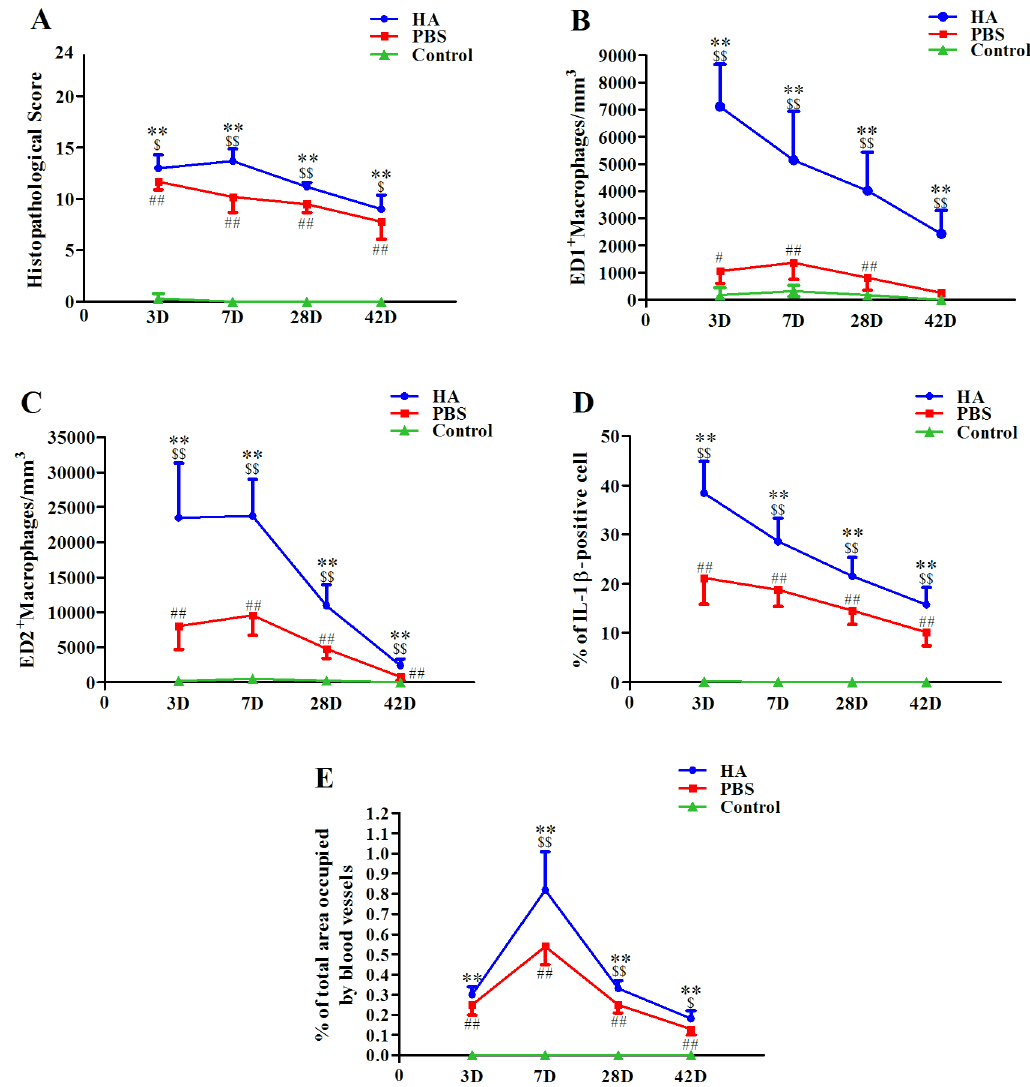
Fig 3. Dynamic expressions of acute inflammation characteristics after intratendinous injections. Histopathological score (A), ED1+ macrophage density (B), ED2+ macrophage density (C), the proportion of IL-1 β + cells (D), and the proportion of neovascularization areas (E) after an intratendinous injection with hyaluronate (HA), phosphate buffered saline (PBS), or neither (Control: needle punctures only). * /# compare with Control group; $ compare with PBS group; $/# p < 0.05; ** /$ $/## p <